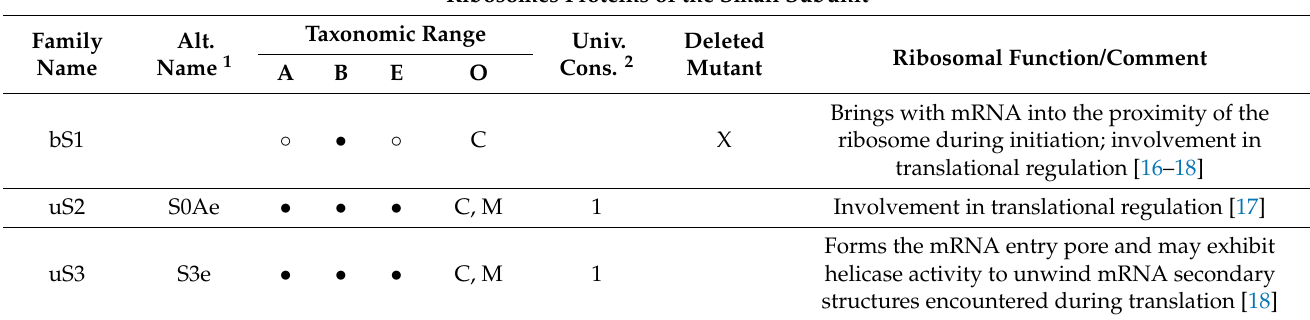
Table 2. Ribosomal proteins classified by taxonomic range based on sequence and structural informa- tion